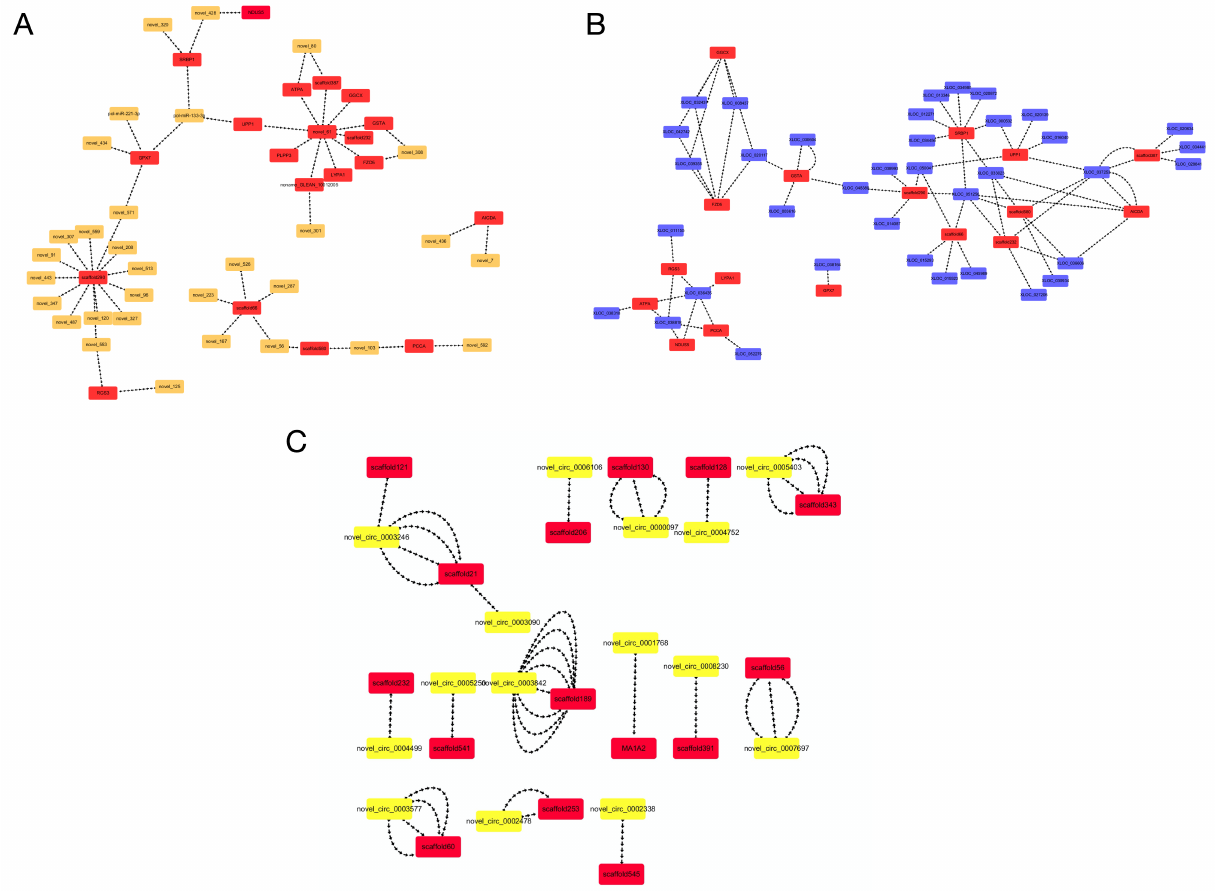
Figure 9. miRNA/lncRNA/circRNA and cor-DEGs-DEPs genes relationship network between infertile and fertile group in Paralichthys olivaceus . ( A ) miRNA and cor-DEGs-DEPs genes relationship network. ( B ) lncRNA and cor-DEGs-DEPs genes relationship network. ( C ) circRNA and cor-DEGs-DEPs genes relationship